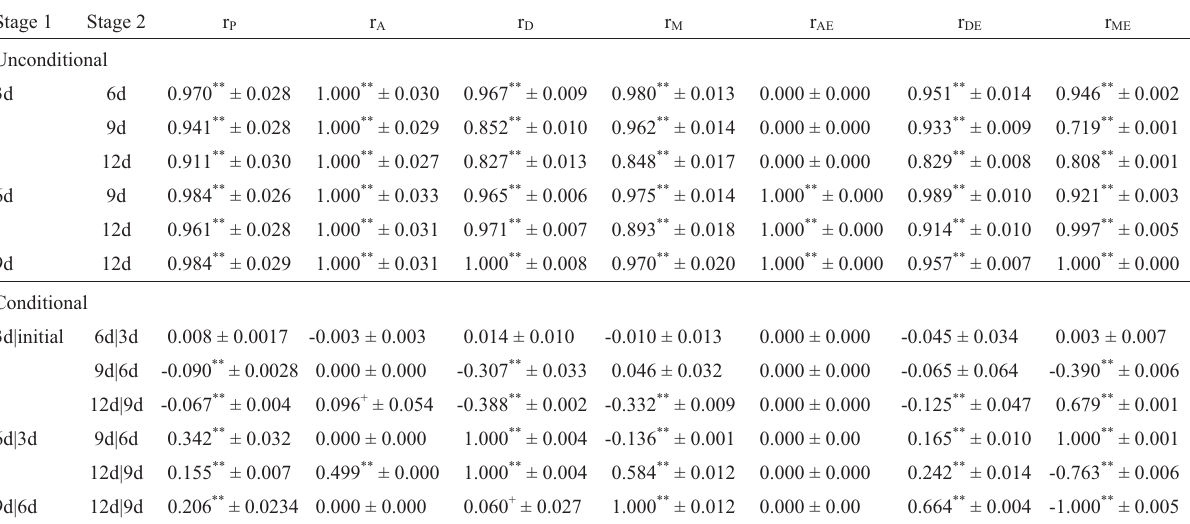
Table4 -Estimationofunconditionalandconditionalcorrelationcoefficientsforspongegourd( Luffacylindrical (L)Roem.)fruitlengthatfourstagesof